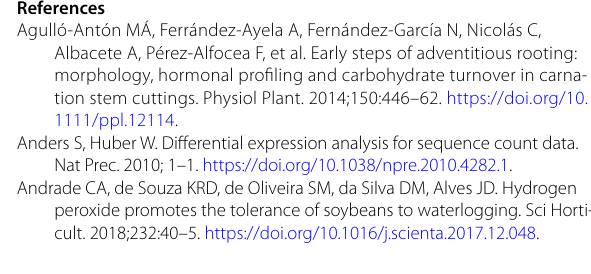
Fig. S5. Gene ontology classification and enrichment analysis of the differ- entially expressed genes in CK vs . T1, CK vs . T2, and T1 vs . T2 comparisons. Fig. S6. KEGG pathway classification (A) and enrichment analysis (B) of the differentially expressed genes in CK vs . T1, CK vs . T2, and T1 vs . T2 compari-